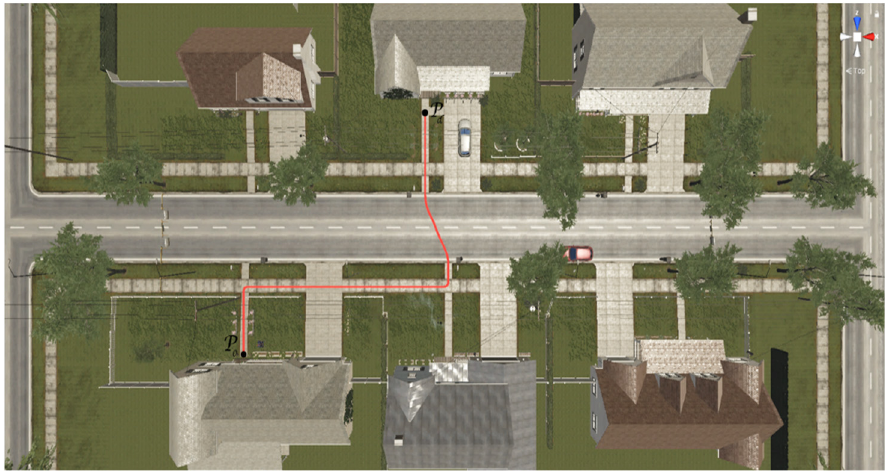
Figure 17. Autonomous assistance task: movement of the standing human–wheelchair system from a house located in P o to another house located in point P d